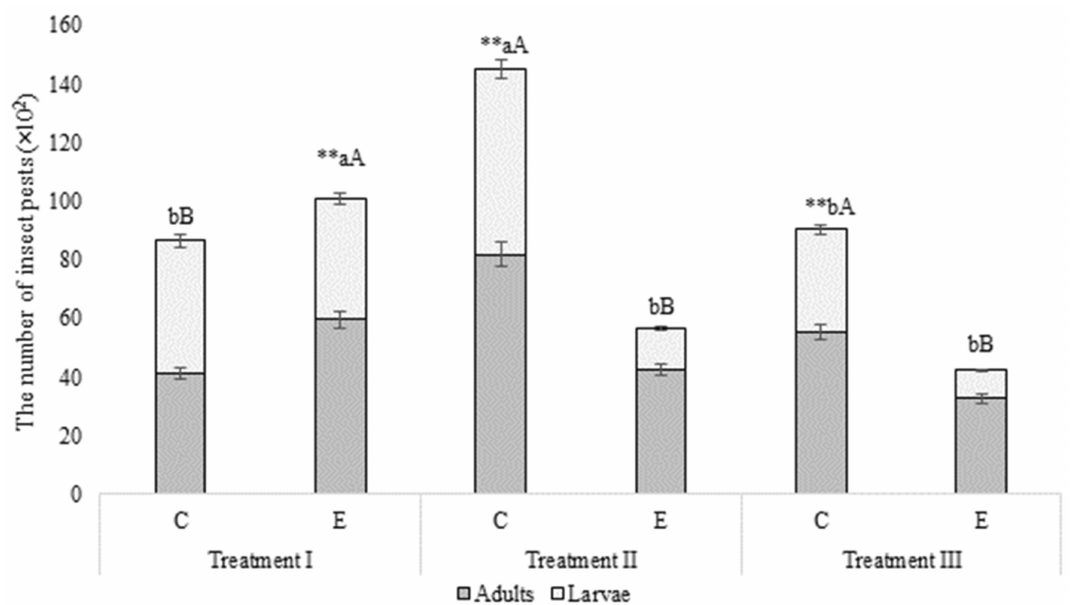
Figure 2. Number of larvae and adults in all treatments. ** Statistically significant di ff erences ( p < 0.05) in the number of insect between limewash and biocidal paint in every treatment; di ff erent lowercase in the number of larvae between limewash and biocidal paint in every treatment are significantly di ff erent ( p < 0.05); di ff erent uppercase letters in the number of adults between limewash and biocidal paint in every treatment are significantly di ff erent ( p < 0.05); Mann-Whitney U test was used; The standard error of measurement (SEM) is indicated on the bar.